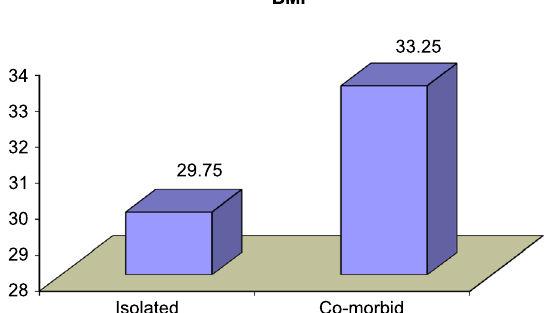
isolated versus the comorbid status of the patients. The higher the BMI, the more the risk of knee